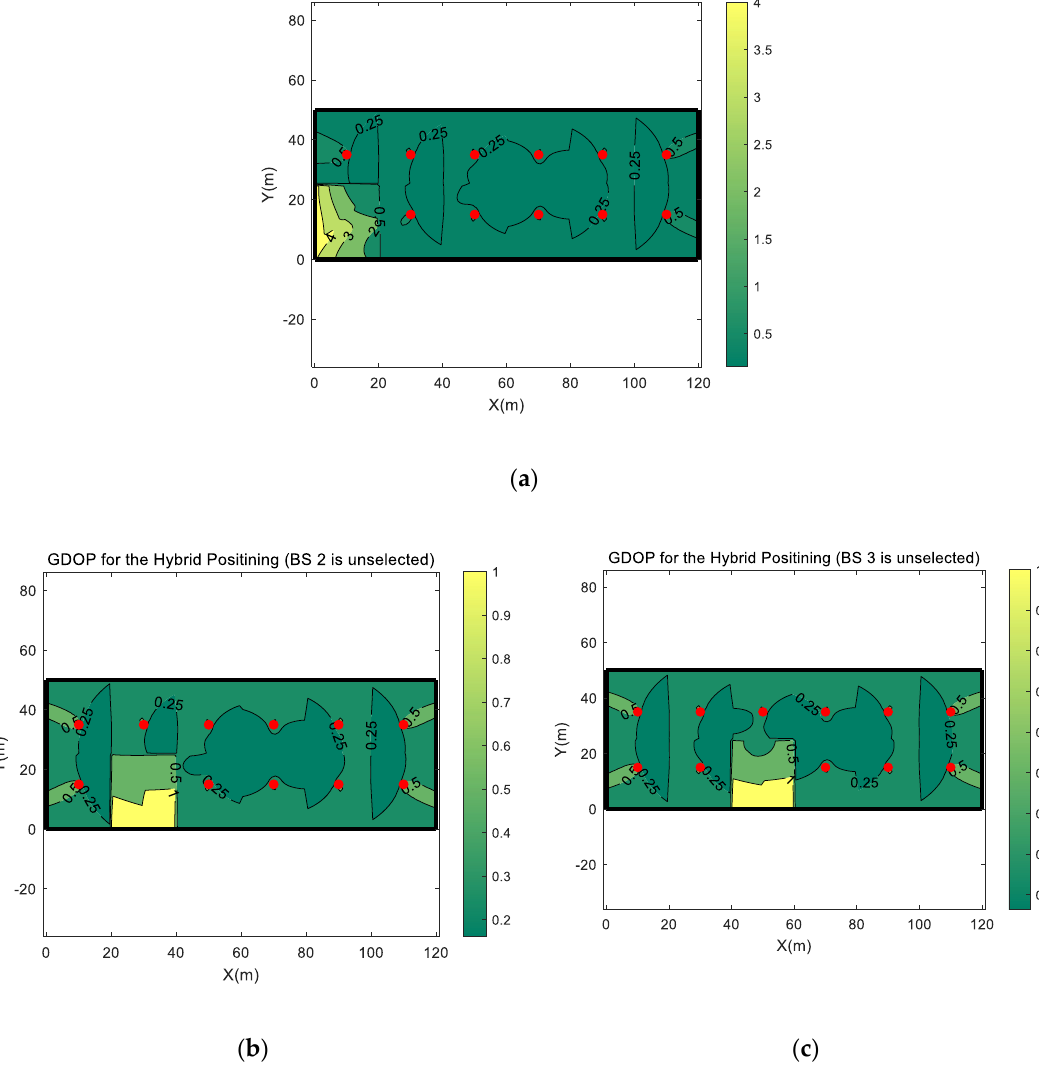
Figure 7. The GDOP distribution of the hybrid positioning when one of the BSs is not selected for positioning. ( a ) The GDOP distribution when BS 1 is not selected. ( b ) The GDOP distribution when BS 2 is not selected. ( c ) The GDOP distribution when BS 3 is not selected.